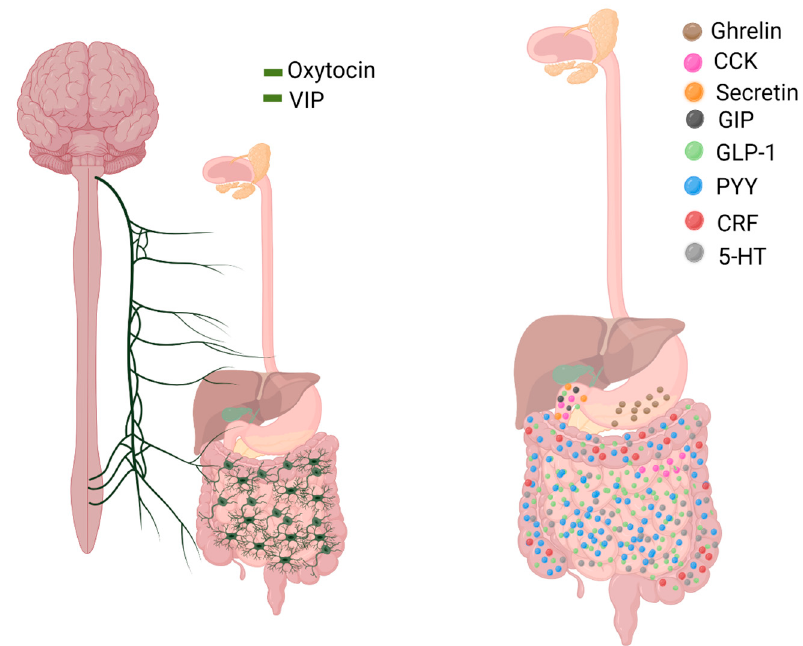
Figure 2. Schematic representation of the cell’s anatomical location producing gut hormones. CCK: cholecystokinin; PYY: peptide YY; VIP: vasoactive intestinal polypeptide; GLP-1/2: glucagon-like peptide 1 and 2; CRF: corticotropin-releasing factor; GIP: glucose-dependent insulinotropic polypeptide; 5-HT: serotonin.